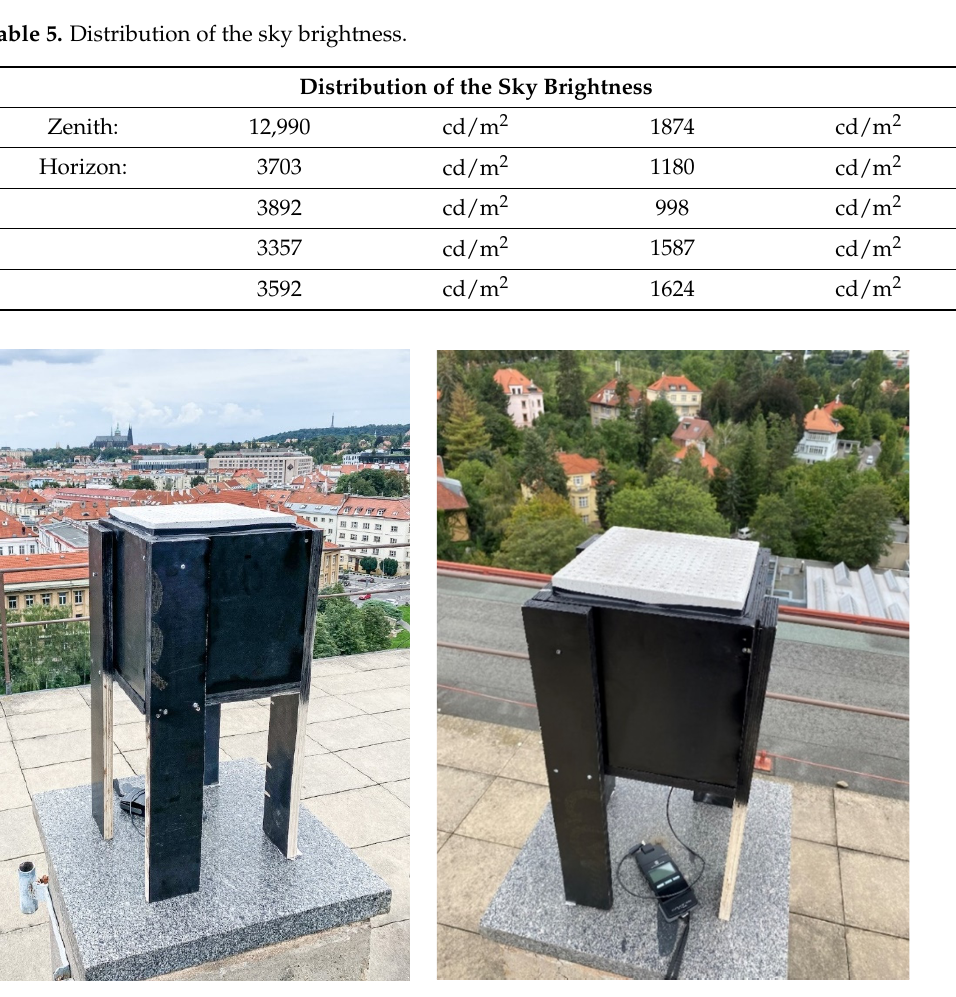
1624 cd/m 2 Figure 25. Plans and sections of the scaled-down model.